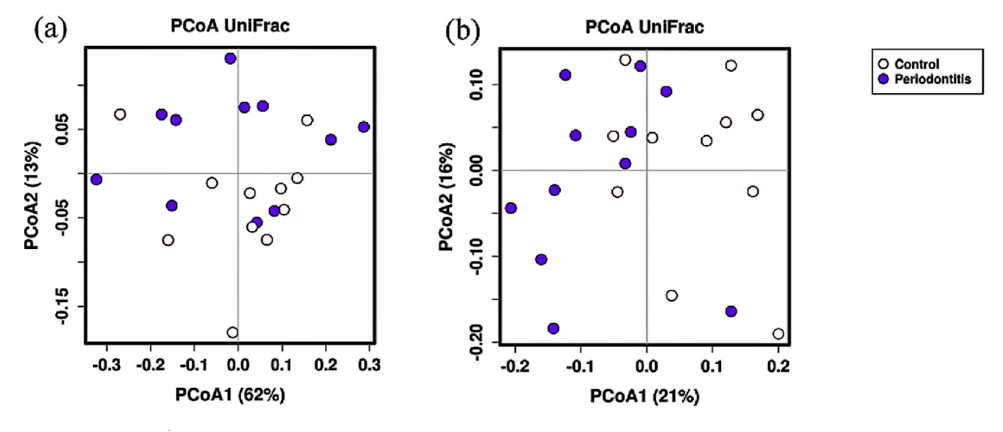
Figure 2. Principal coordinate analysis (PCoA) to assess the difference in beta diversity between the periodontitis and control groups. Plots were based on weighted UniFrac distance ( a ), unweighted UniFrac distance ( b ), and relative abundances of bacterial operational taxonomic units.